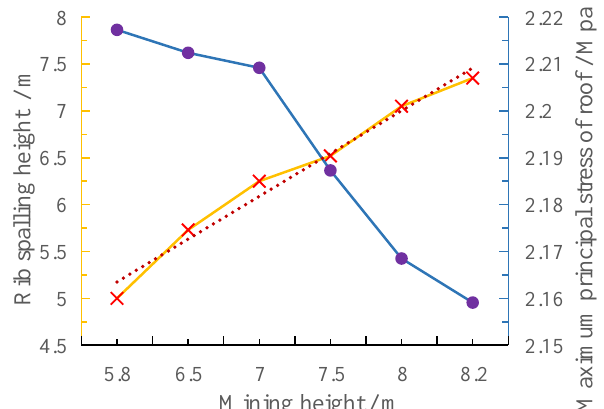
Figure 13. Diagram of the maximum principal stress relationship between coal seam mining height and coal wall plate height, and coal seam and roof plate. Blue line is the maximum principal stress, light red is the rib spalling height.